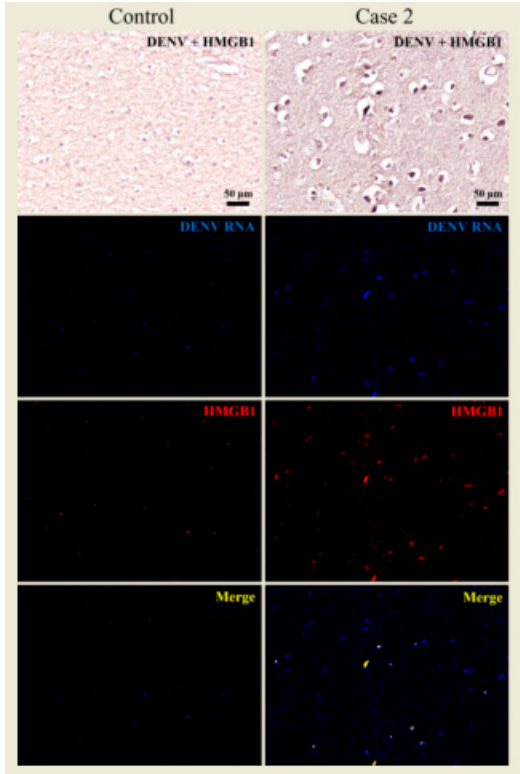
Figure 7. Co-staining of DENV and HMGB1 in the brain tissue of fatal case 2. In the dengue case,